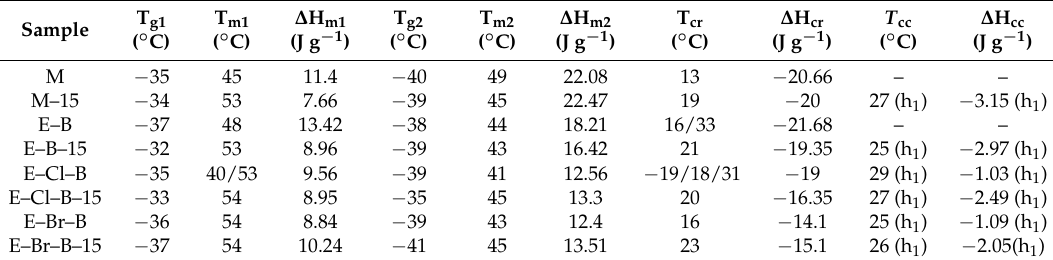
Table 5. DSC data of EPDM/butyl rubber